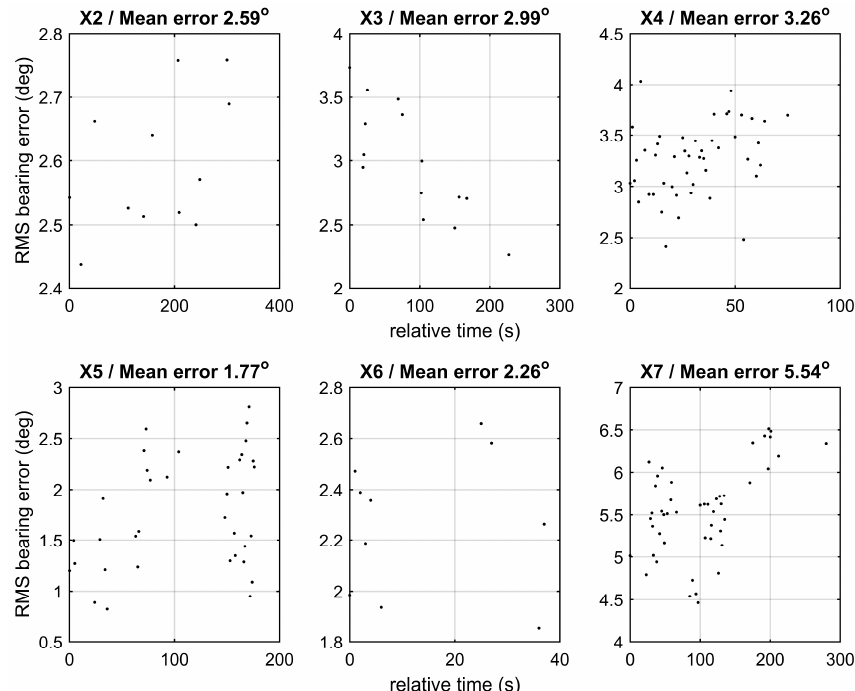
Figure 17. Bearing estimation RMS errors for sperm whale X during stations X2–X7.